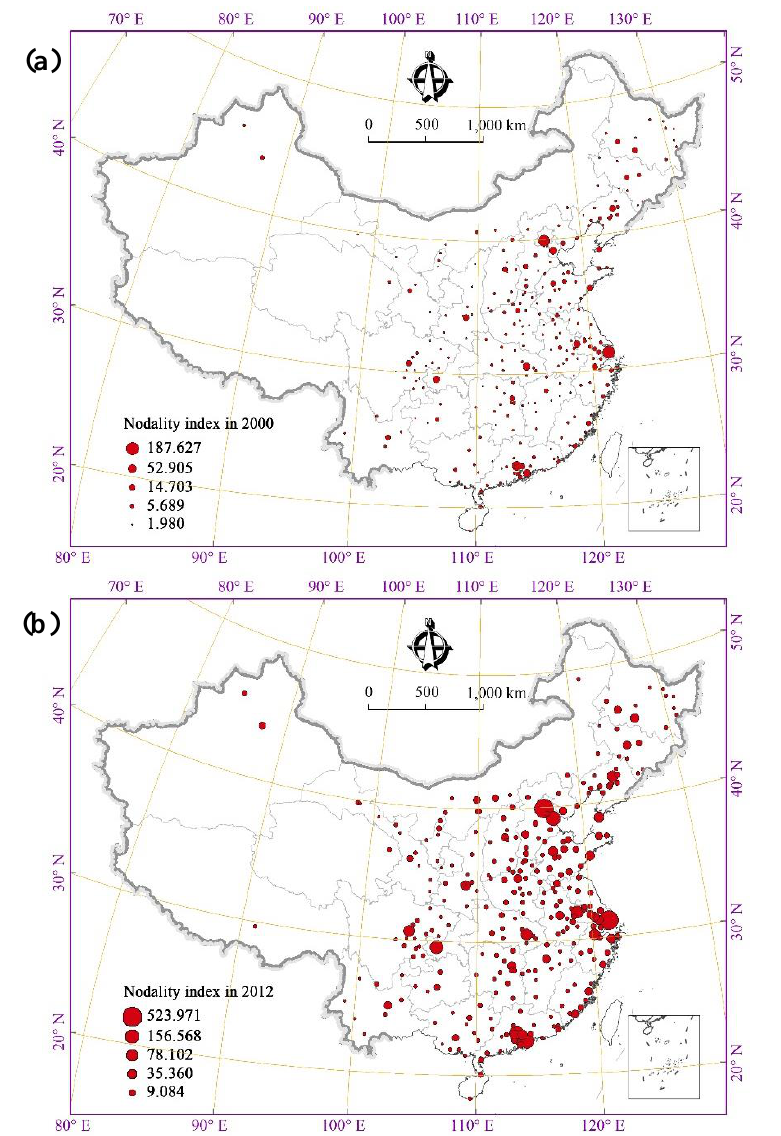
Figure 1. Nodality index in relation to the central cities for different years in China for year ( a ) 2000 and ( b )